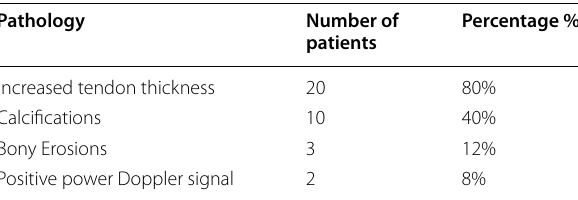
Table 5 The distribution of ultrasound findings detected compatible with enthesis